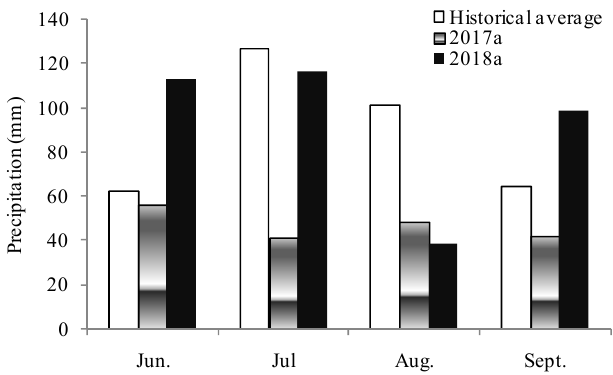
Figure 1. Distribution of the historical average precipitation and monthly precipitation in growing season of summer maize.